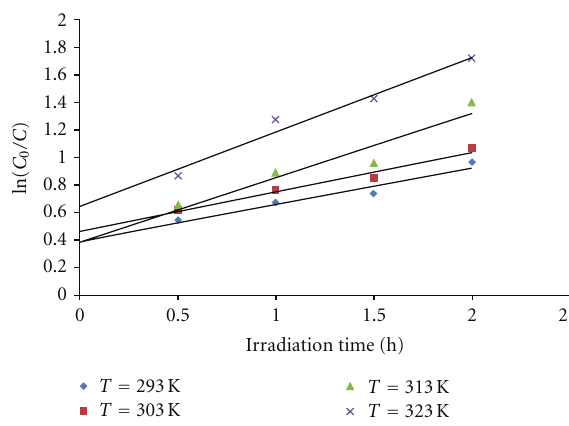
Figure 7: Linear fit of reactions at di ff erent temperature (initial pH: 6, catalyst concentration: 60mg/L).